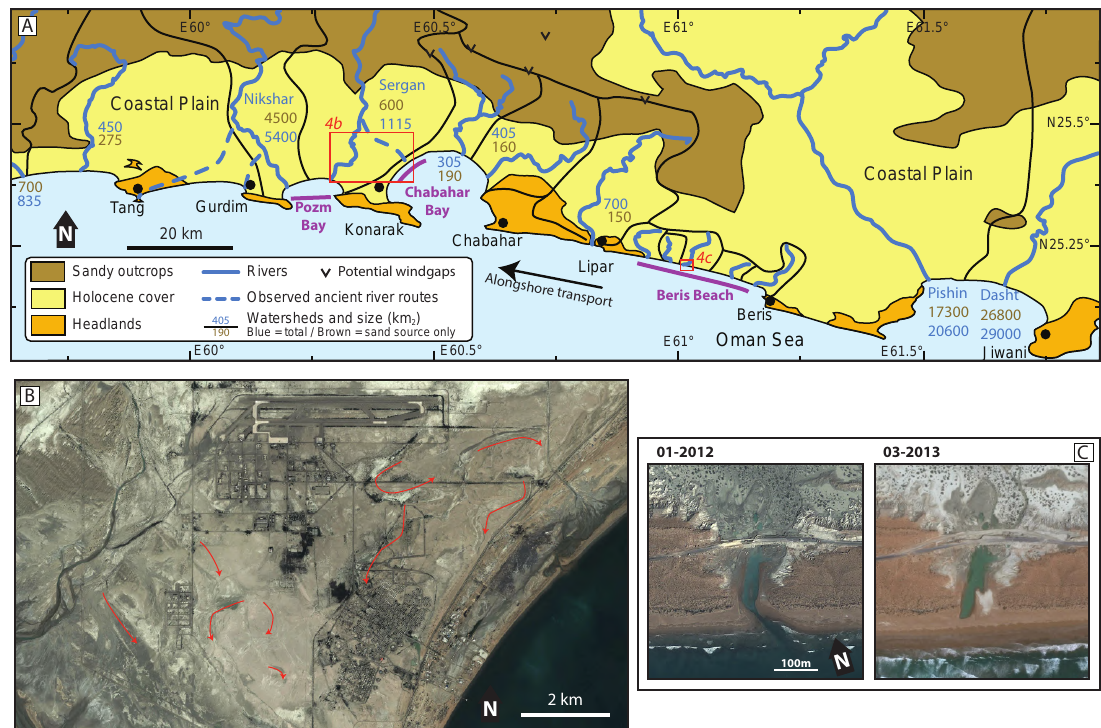
Figure 4. Fluvial input in the Chabahar region. ( A ) Map of Chabahar region with the watersheds boundaries. Total watershed size is expressed in blue, whereas the watershed area draining hard tertiary bedrock (sand source for beaches) is expressed in brown. Purple = studied regions. ( B ) Google Earth satellite image near Konarak airport. Abandoned river channels of the Sergan River are visible in the landscape (red arrows. ( C ) Beach destruction and healing throughout flood events (Beris). N 25.209 ◦ E 61.022 ◦ . Images from Google